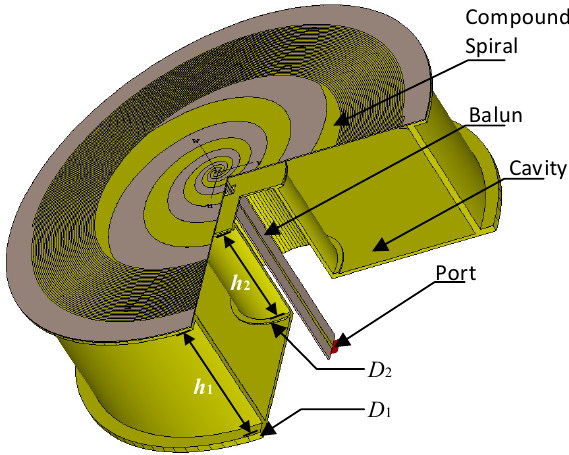
Figure 1. Overall view of the cavity-backed compound-spiral antenna